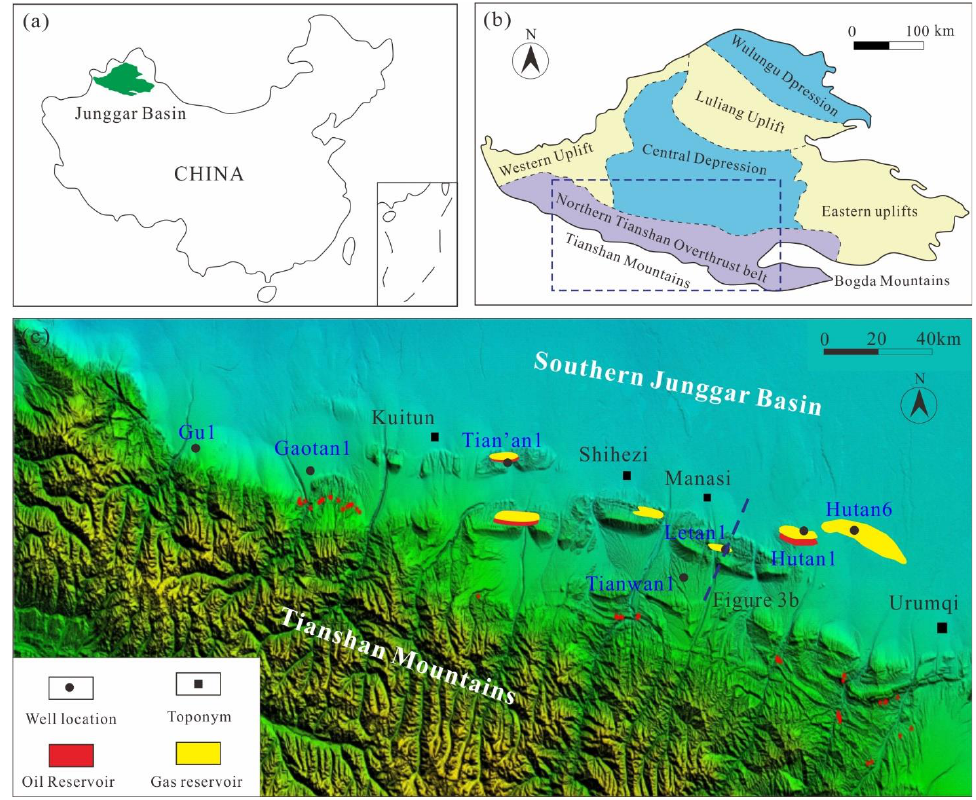
Figure 1. ( a ) Map of the Junggar Basin in China; ( b ) the division of tectonic units in the Junggar Basin and the location of southern Junggar Basin; ( c ) digital elevation model of the southern Junggar Basin.